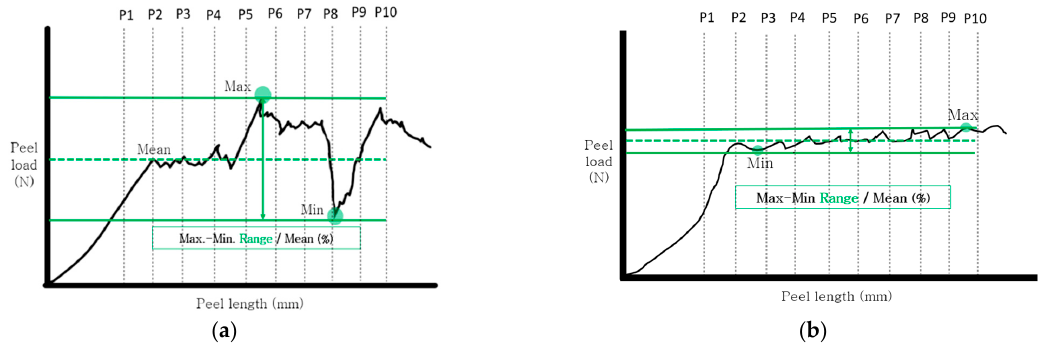
Figure 11. A stability analysis comparison example of percent relative range of peel load; ( a ) case with high percent relative range, ( b ) case with low percent relative range.